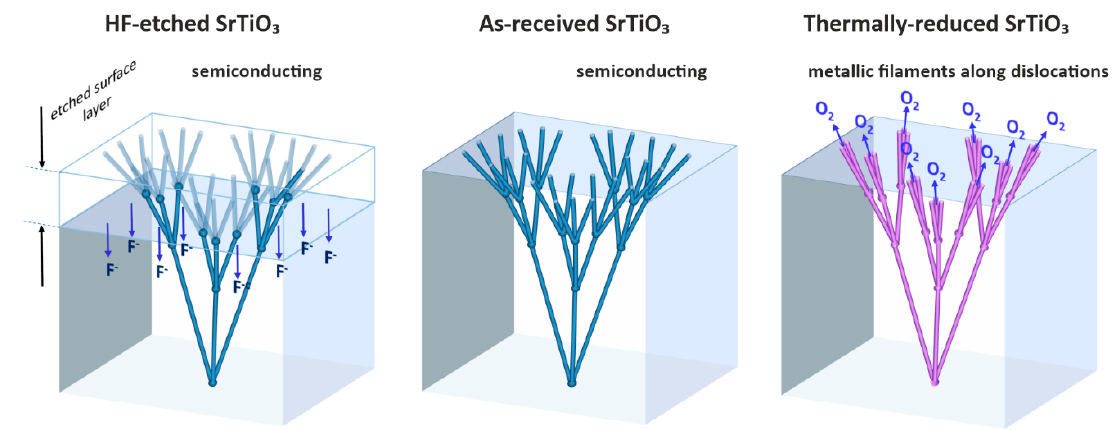
Figure 9. Illustration of the model of a hierarchical tree of dislocations acting as preferentially conducting paths in the surface layer of SrTiO 3 . The three sample states, HF-etched, as-received and thermally reduced, are depicted.